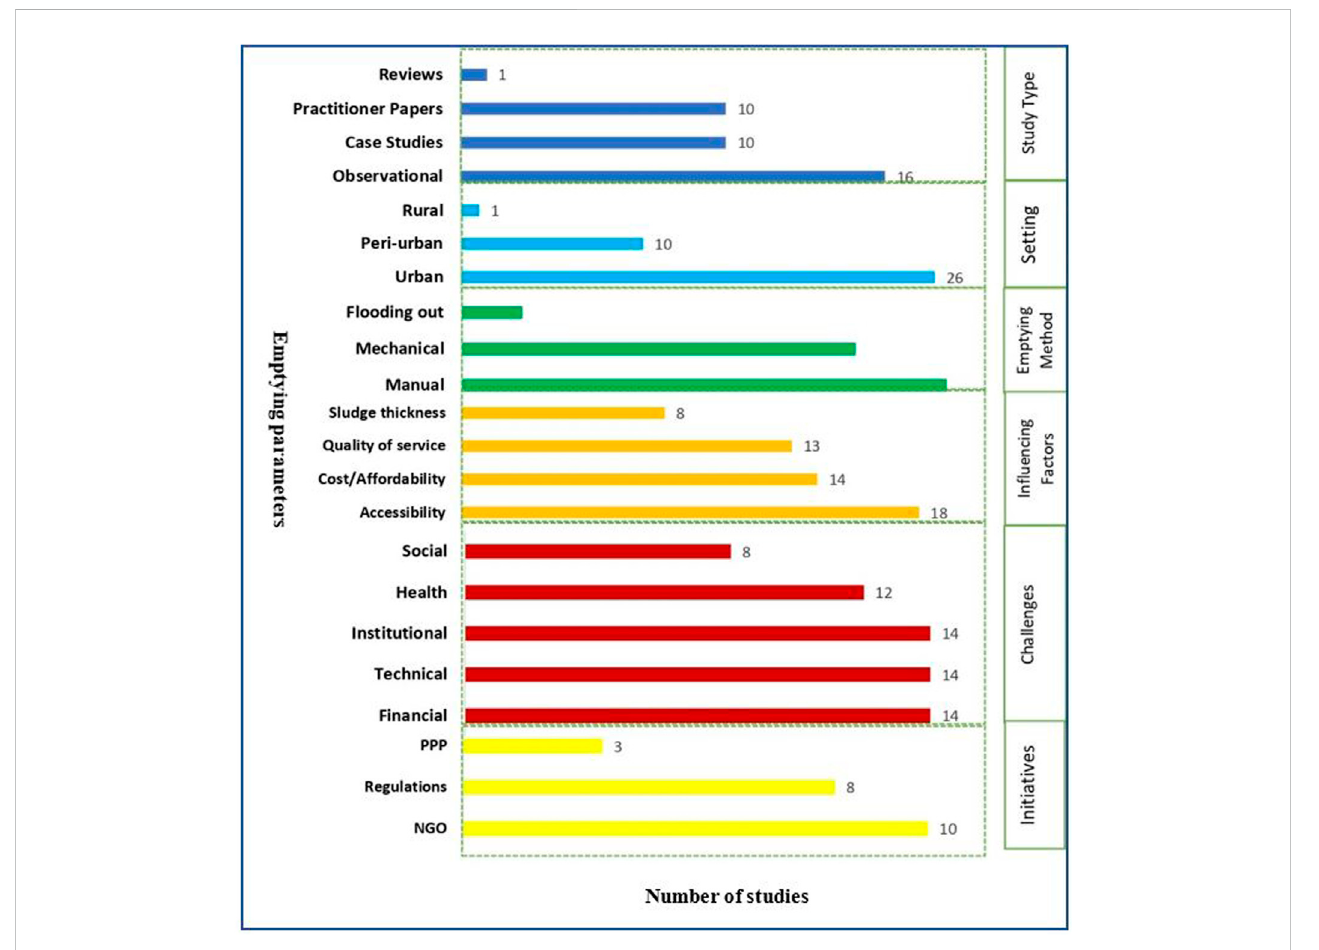
FIGURE 3 Characteristics of studies included in the review of feacal sludge emptying in Sub-Saharan Africa, South and Southeast